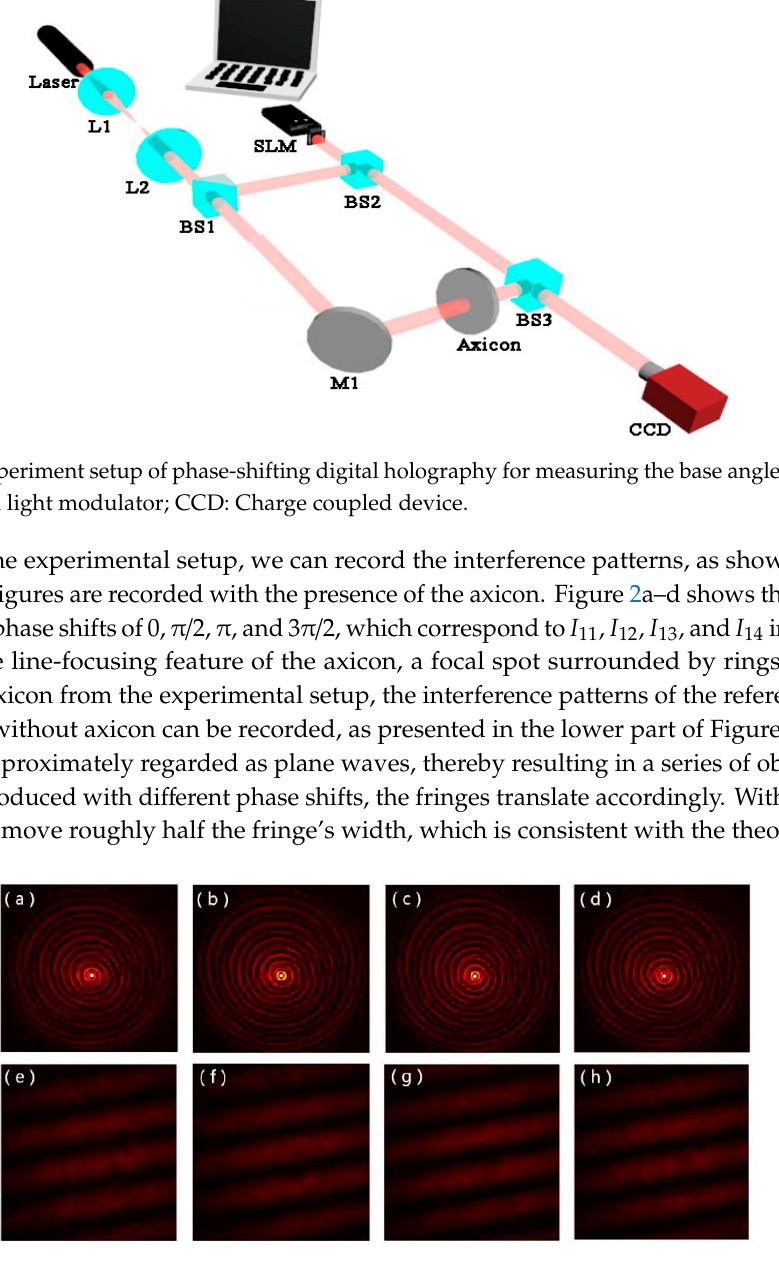
Figure 2. ( a – d ) Interference patterns of the light passing through the axicon interfering with the reference light with di ff erent phase shift. ( e – h ) Interference fringes of the plane wave interfering with the reference light with di ff erent phase shift. ( a , e ) Phase shifts of 0; ( b , f ) phase shifts of π / 2; ( c , g ) phase shifts of π ; ( d , h ) phase shifts of 3 π /2.